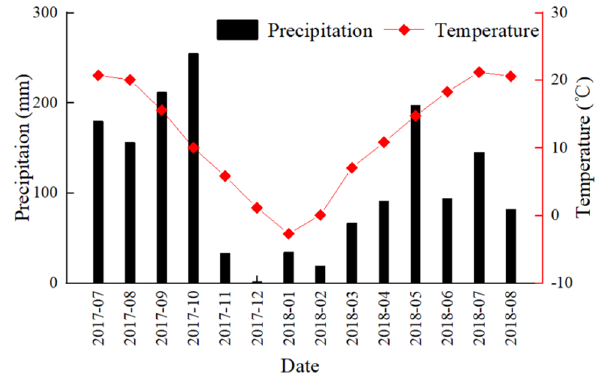
Figure 1. Monthly mean air temperature (line) and precipitation (bar) from July 2017 to August 2018 in the Three Gorges Reservoir